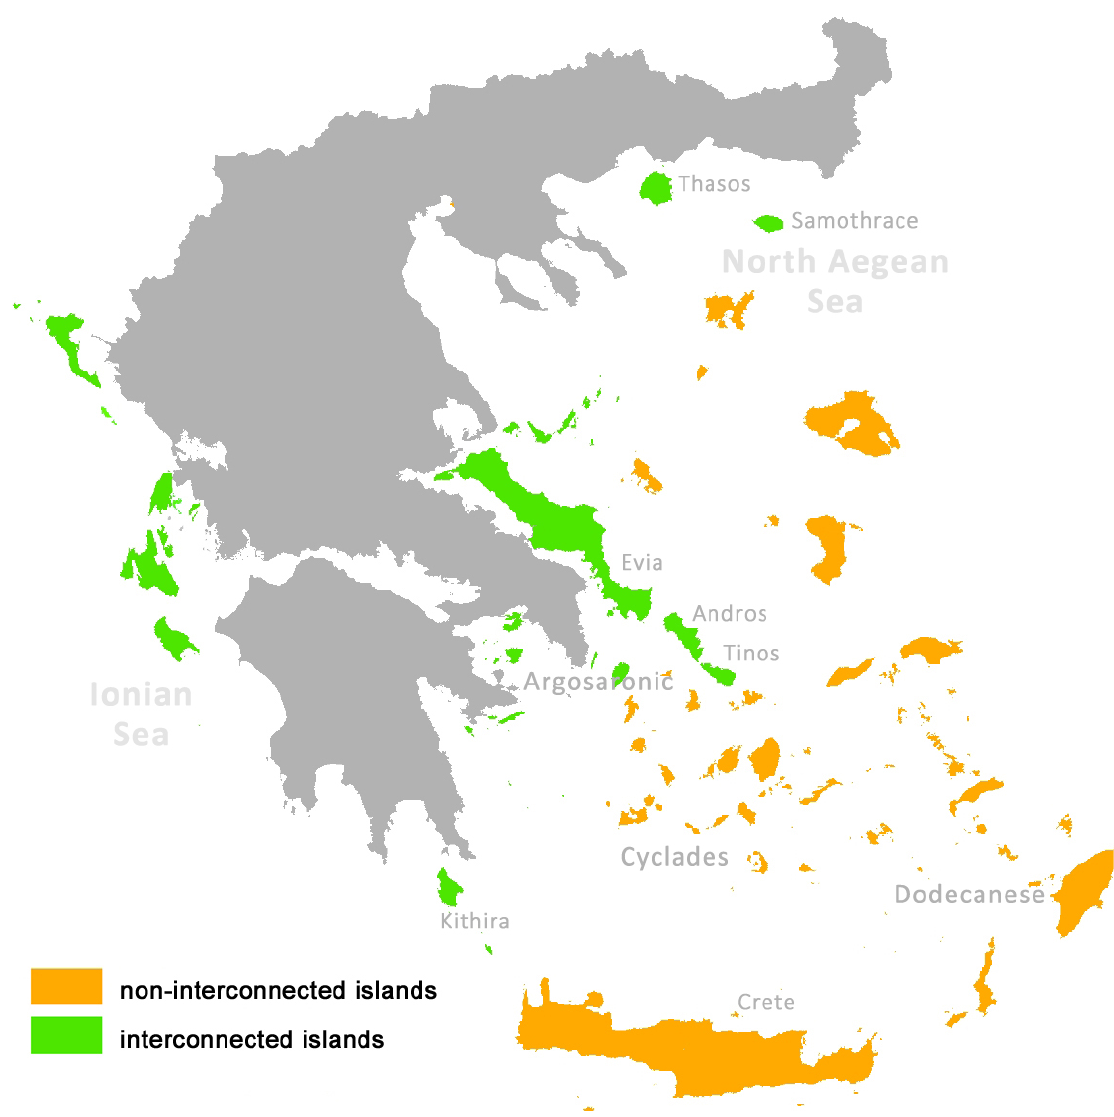
Figure 1. Interconnected and non-interconnect Greek islands [33].